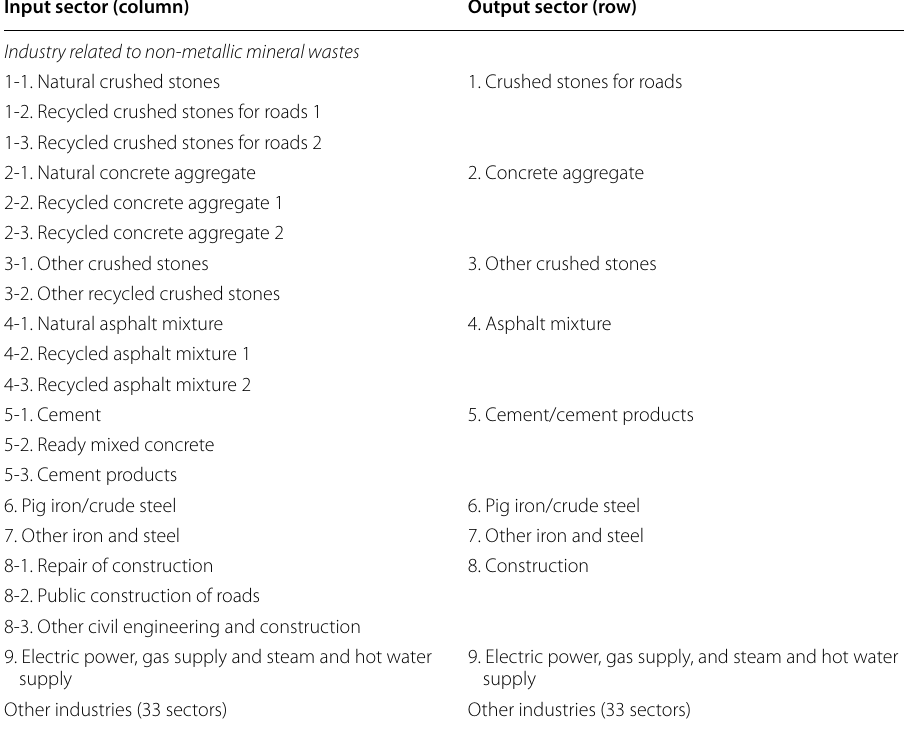
Table 2 Industrial classification in the IO table for analysis of non‑metallic mineral wastes Input sector